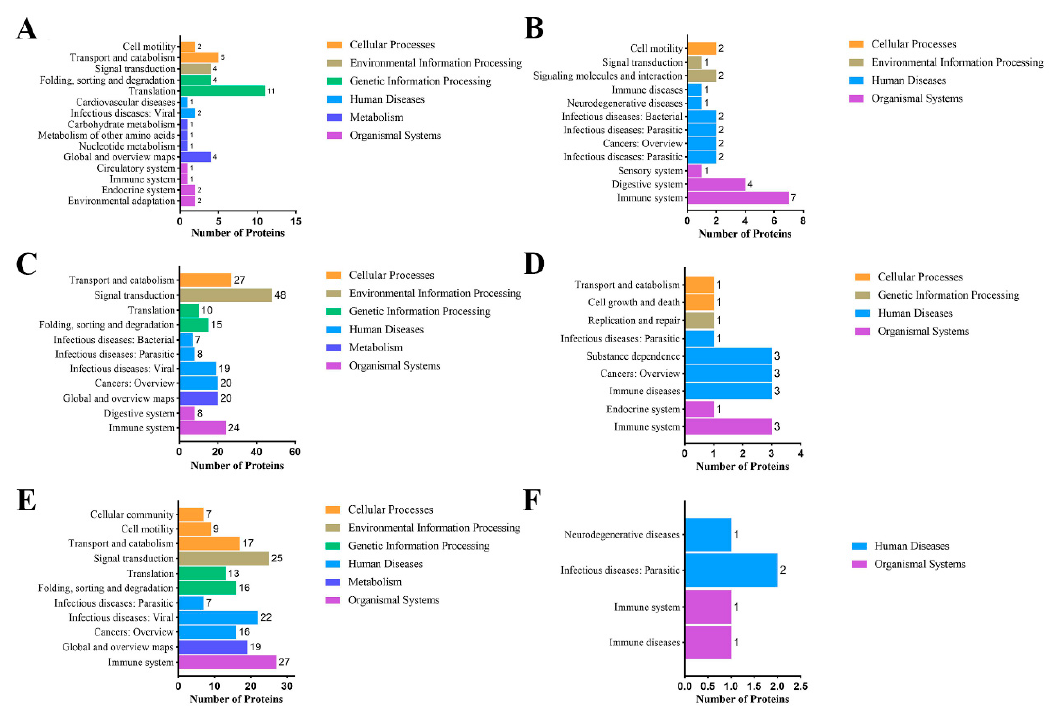
Figure 6. KEGG pathway analysis of significantly different MFGM proteins comparing the heat treatment groups with RAW. ( A , C , E ) are significantly downregulated MFGM proteins, and ( B , D , F ) are significantly upregulated proteins of SP vs. RAW, UP vs. RAW, and UHT vs. RAW, respectively.